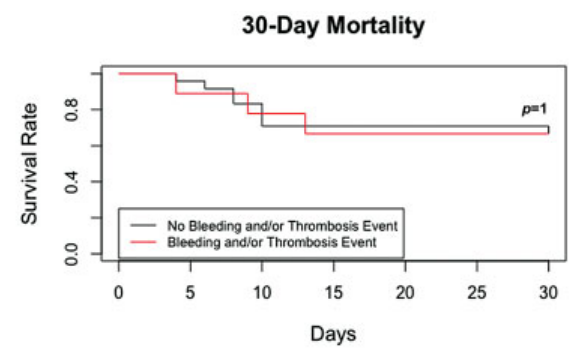
Fig. 1 Kaplan-Meier curve of 30-day mortality. Net mortality was